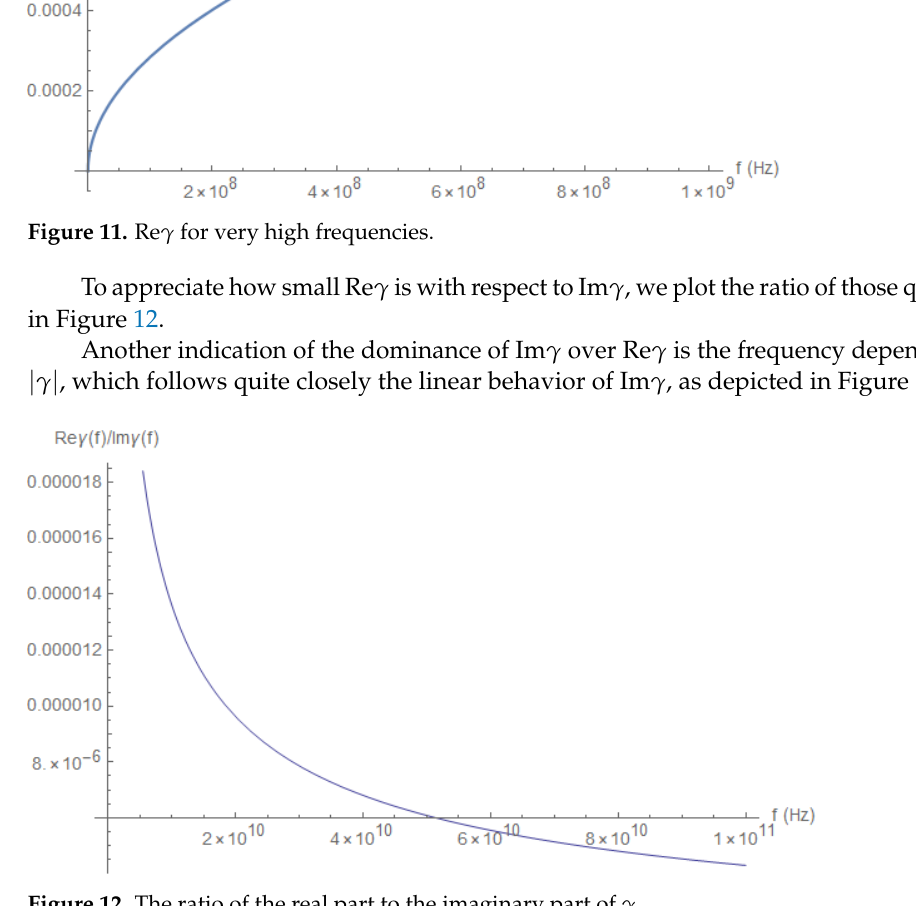
Figure 12. The ratio of the real part to the imaginary part of γ